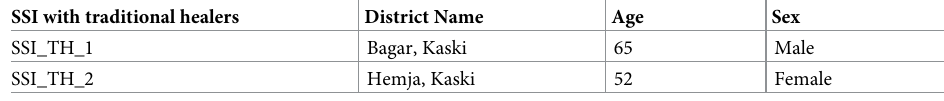
Table 4. Semi Structure Interview for a traditional health service provider.